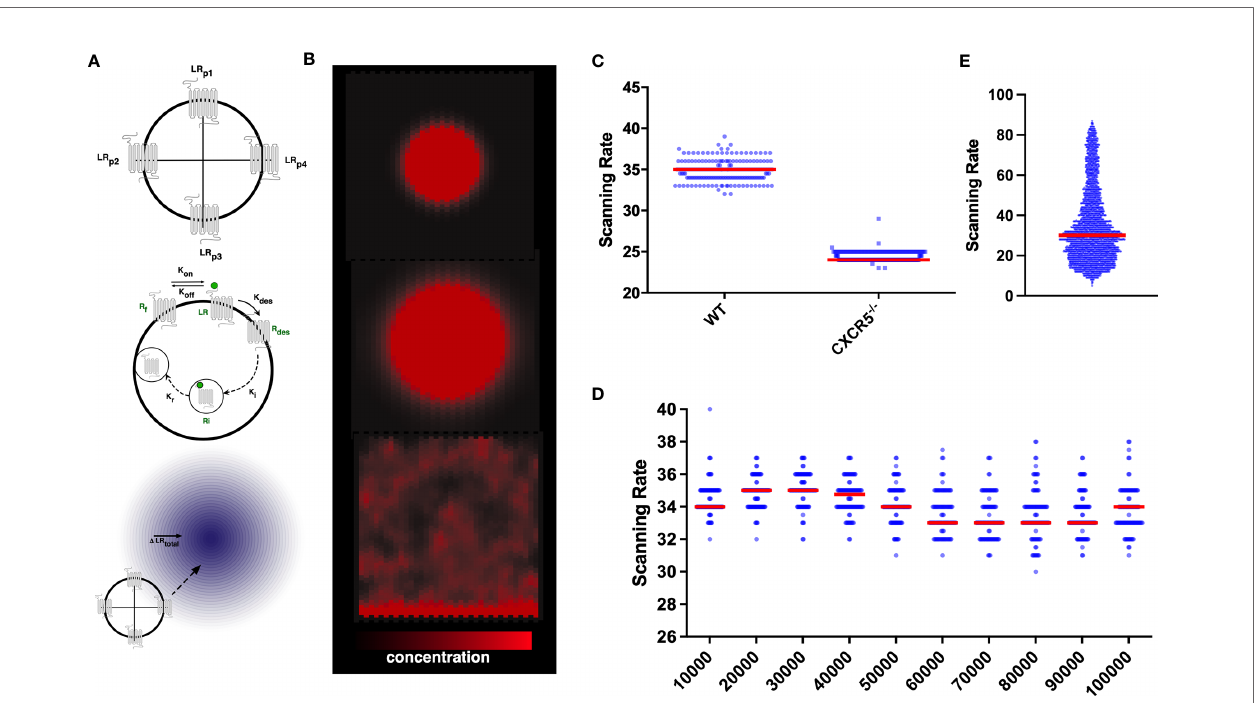
FIGURE 1 | In silico CXCR5 modelling: Graphical Overview of the gradient sensing algorithm (A) , including receptor internalization and recycling (B) in the context of CXCL13 gradients (C) Quanti fi cation of scanning rates in wild-type and CXCR5 de fi cient B cells. (D) Quantifying scanning rates when perturbing total receptor numbers holding all other parameters fi xed at baseline values. Median values are shown with error bars representing the I.Q.R. (E) Distributions of scanning rates observed from our global parameter perturbation analysis.